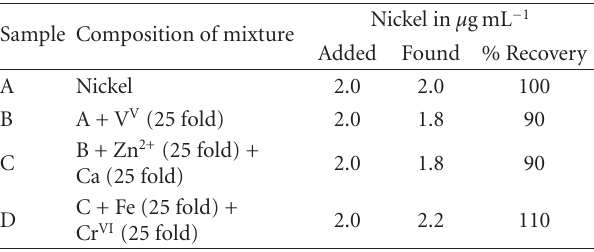
Table 3: Determination of nickel in synthetic mixtures. Table 4: Determination of nickel in tobacco samples.